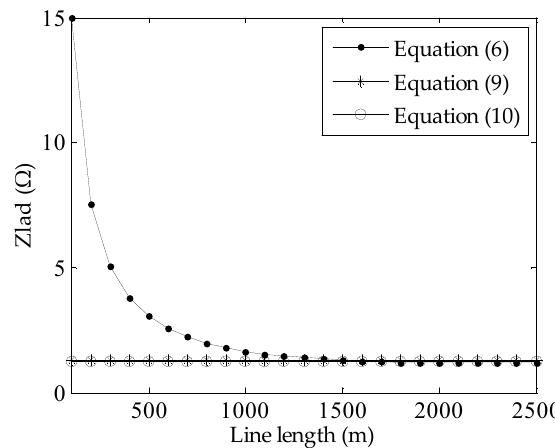
Figure 5. The system equivalent impedance versus the neutral line length.